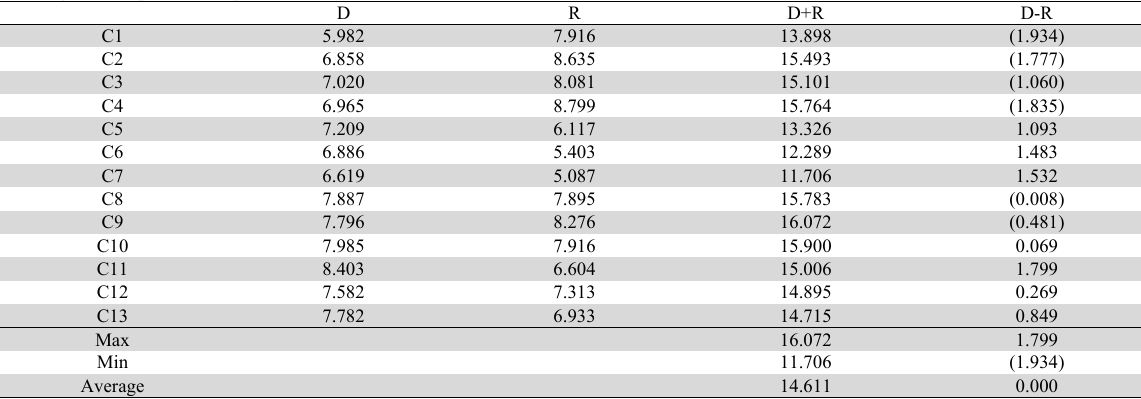
Table 12 Driving and dependence power of